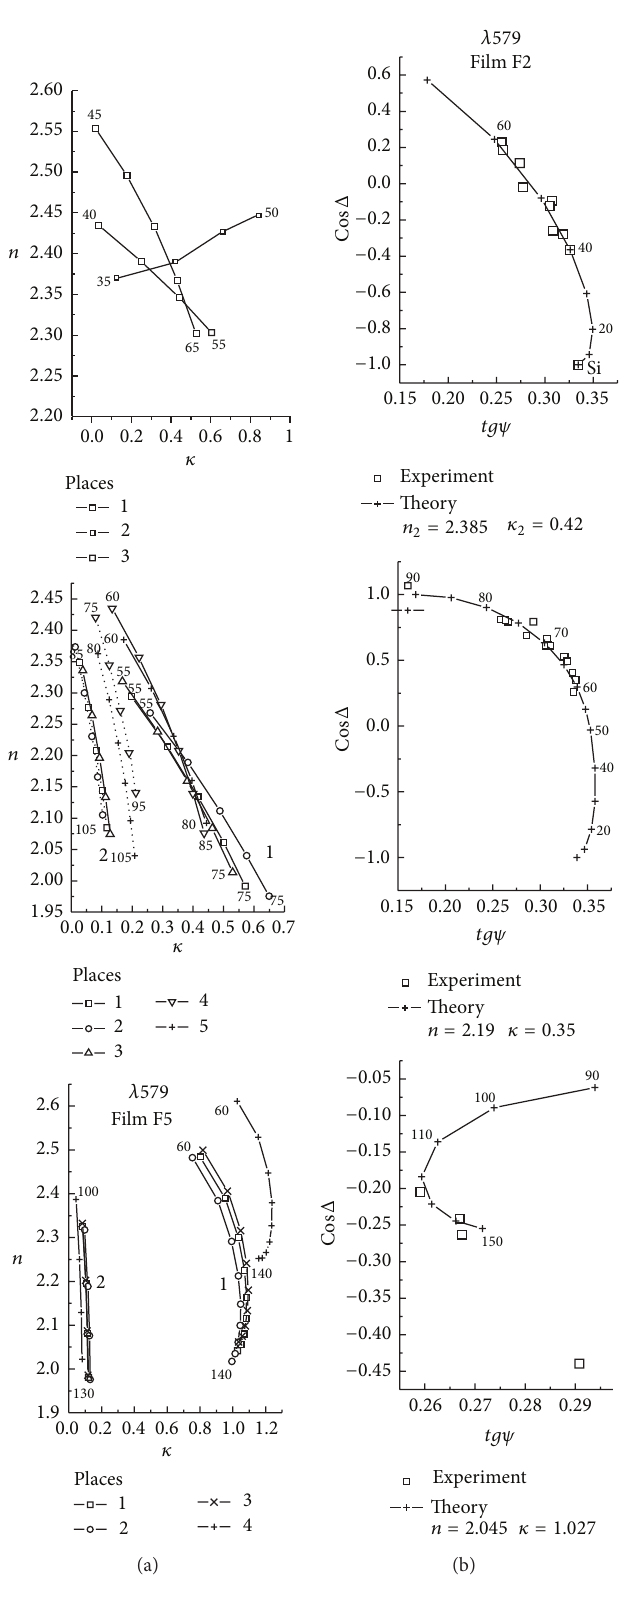
Figure 2: Range of possible values of refractive index 𝑛 and index of extinction 𝜅 (a, curves), calculated for CdTe films on silicon; comparison of experimental data with calculated dependence of ellipsometric parameters cos Δ and 𝑡𝑔𝜓 on the film thickness (b). Numbers near markers specify film thickness in nm. Numbers 1 and 2 indicate solution